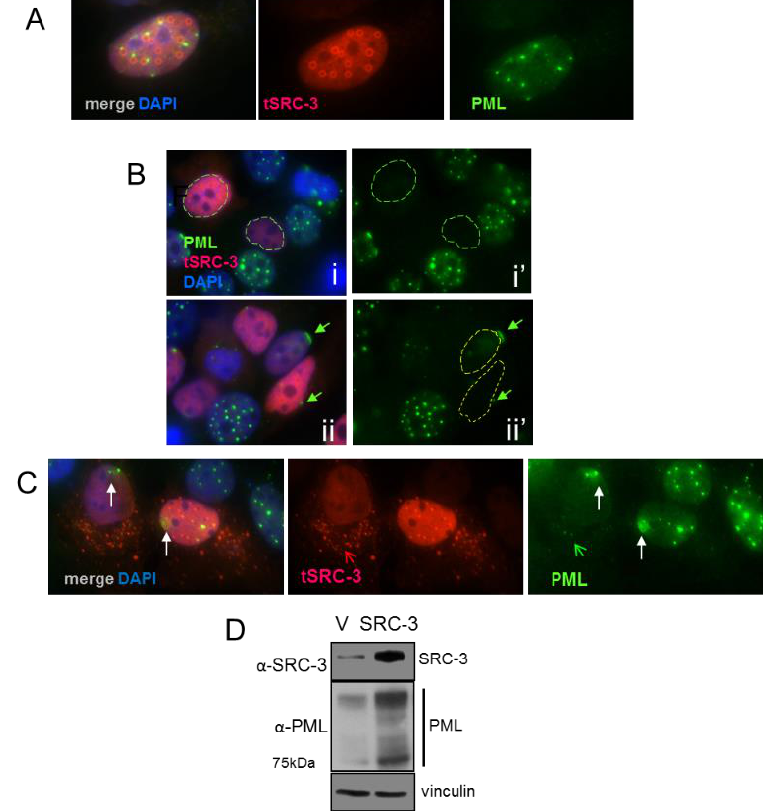
Figure 6. Effects of increased SRC-3 expression on PML: ( A ) IF of PML and SRC-3 in SRC-3 transfected cells shows ring-like aggregates of SRC-3 adjacent to PML bodies. ( B ) Dispersion of PML bodies (circled nuclei in panels i and ii’) in MCF-7 cells containing varying levels of homogenously distributed SRC-3. Nuclear membrane accumulation into caps of PML was observed in a subset of SRC-3 transfected cells (arrow in panels ii and ii’) (63 × magnification). ( C ) Di ff use accumulations of PML form near the nuclear membrane. Cytoplasmic SRC-3(red open arrow) and PML (green open arrow). ( D ) Immunoblot of PML 96hrs following SRC-3 transfection. “V” denotes empty vector control. Vinculin was used as a protein loading control.